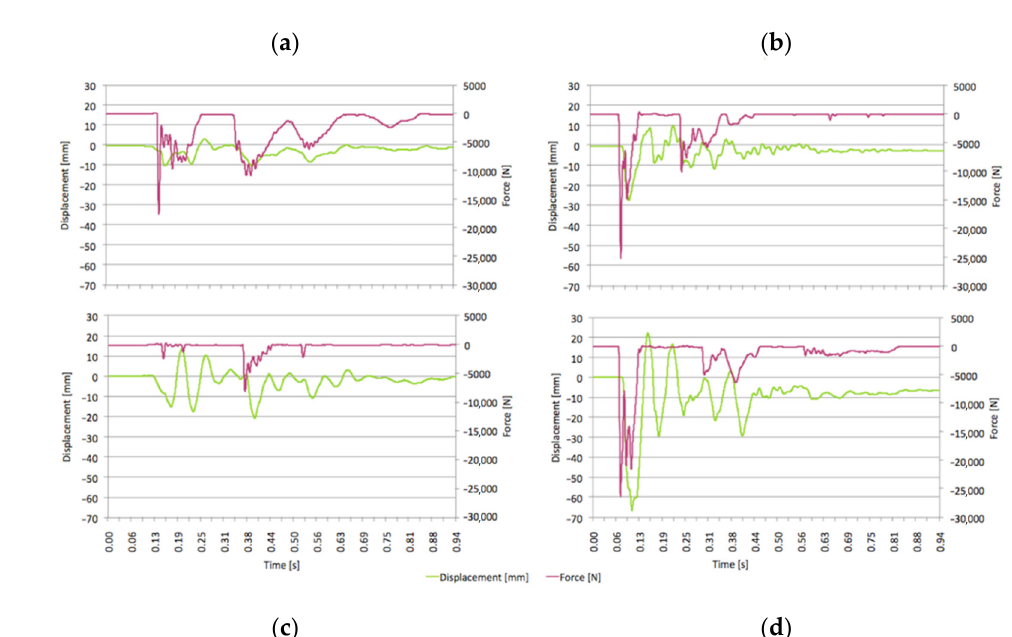
Figure 8. Representative globally transformed Z -axis direction force-displacement results corresponding to C1 for each test in the T1 (a) and the T2 (b) configurations and to C2 for each test in the T1 (c) and the T2 (d) configurations.